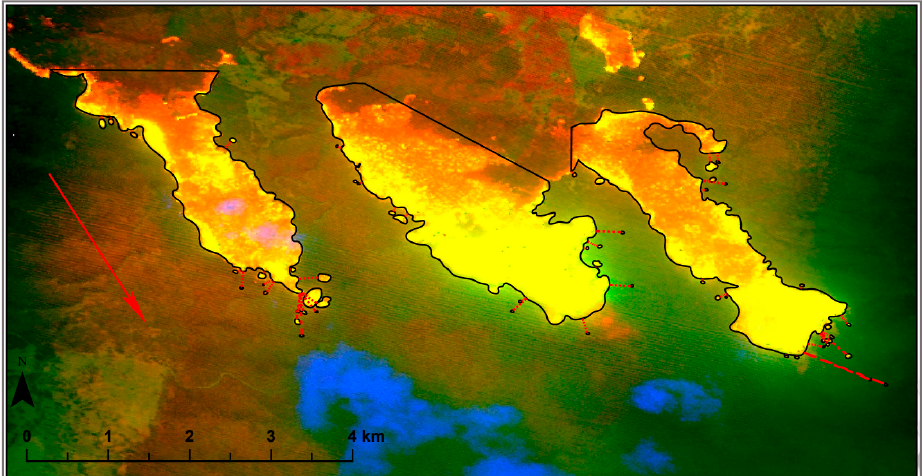
Figure 2. Rural Fire Service (RFS) line scan showing three separate source fires (three largest polygons). Most actively burning fire is yellow, orange is still hot after the main fire front has passed, brown is extinguished, green is unburnt vegetation, and blue is faint signature of the smoke plume. Red dotted lines indicate spot fire (small polygons) distances measured for analysis. The red arrow indicates spread direction.